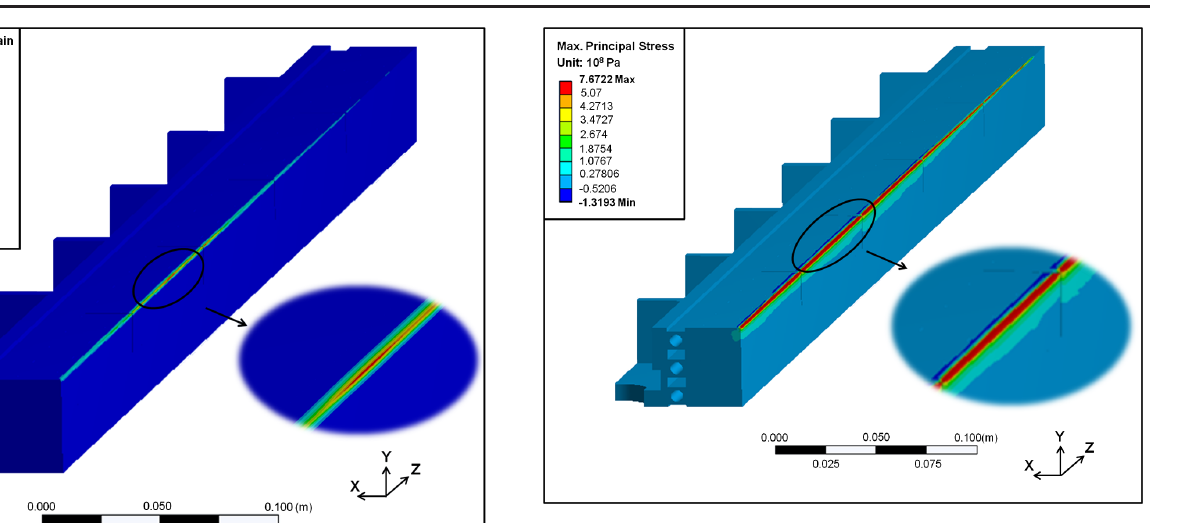
FIG. 26. Contour plot of the maximum principal stress on the collimator jaw assembly. The region of the collimator jaw assembly, where the ultimate tensile strength of W is exceeded, will be subjected to the formation of microcracks and ultimately, spallation. A detailed view is shown in the inset.